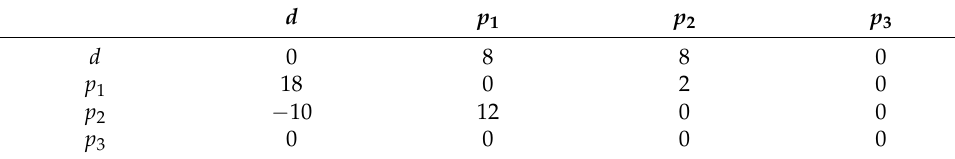
Table 4. Local reputation values.